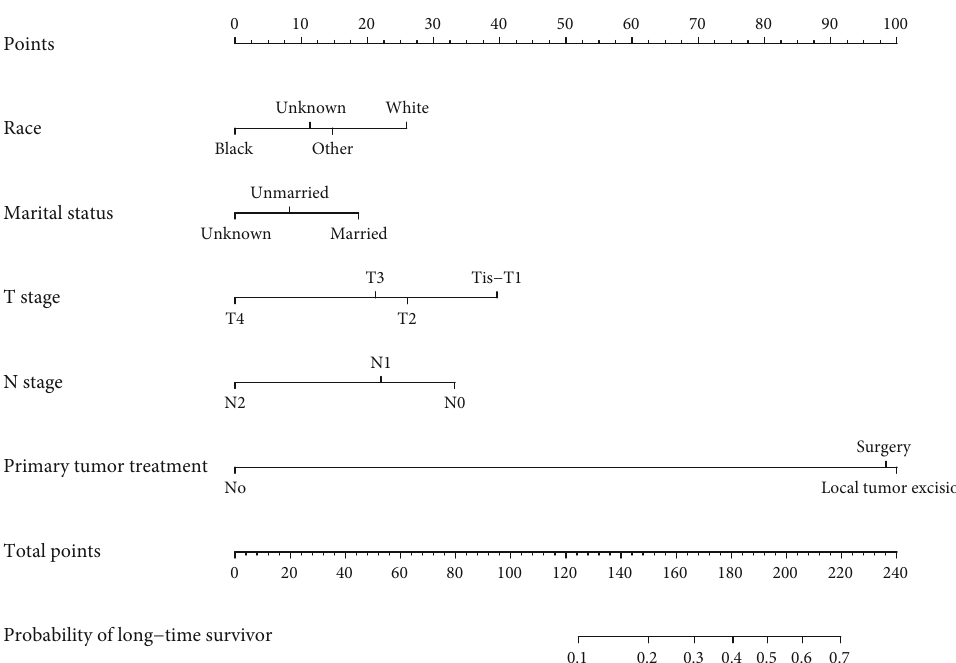
Figure 2: Nomogram to predict the probability of long-time survivor. For example, there was a black (0 point), married (20 points) patient with T1N1M0 (40 points for T1 and 22 points for N1) colorectal SRCC who received radical surgery (98 points). The fi ve values summed to 180 points. For this speci fi c patient, the probability of being a long-time survivor was approximately 0.4.